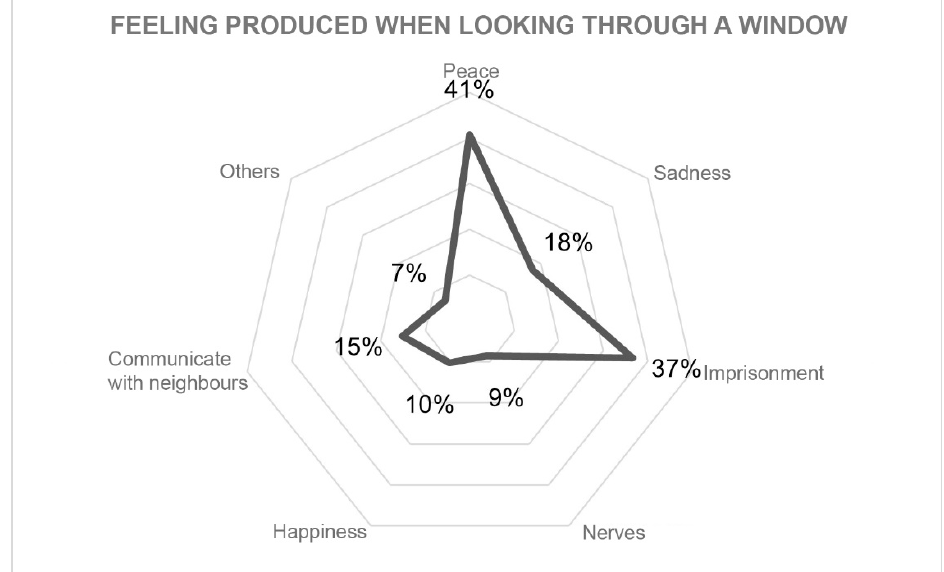
Figure 9. Feeling produced when looking through a window.